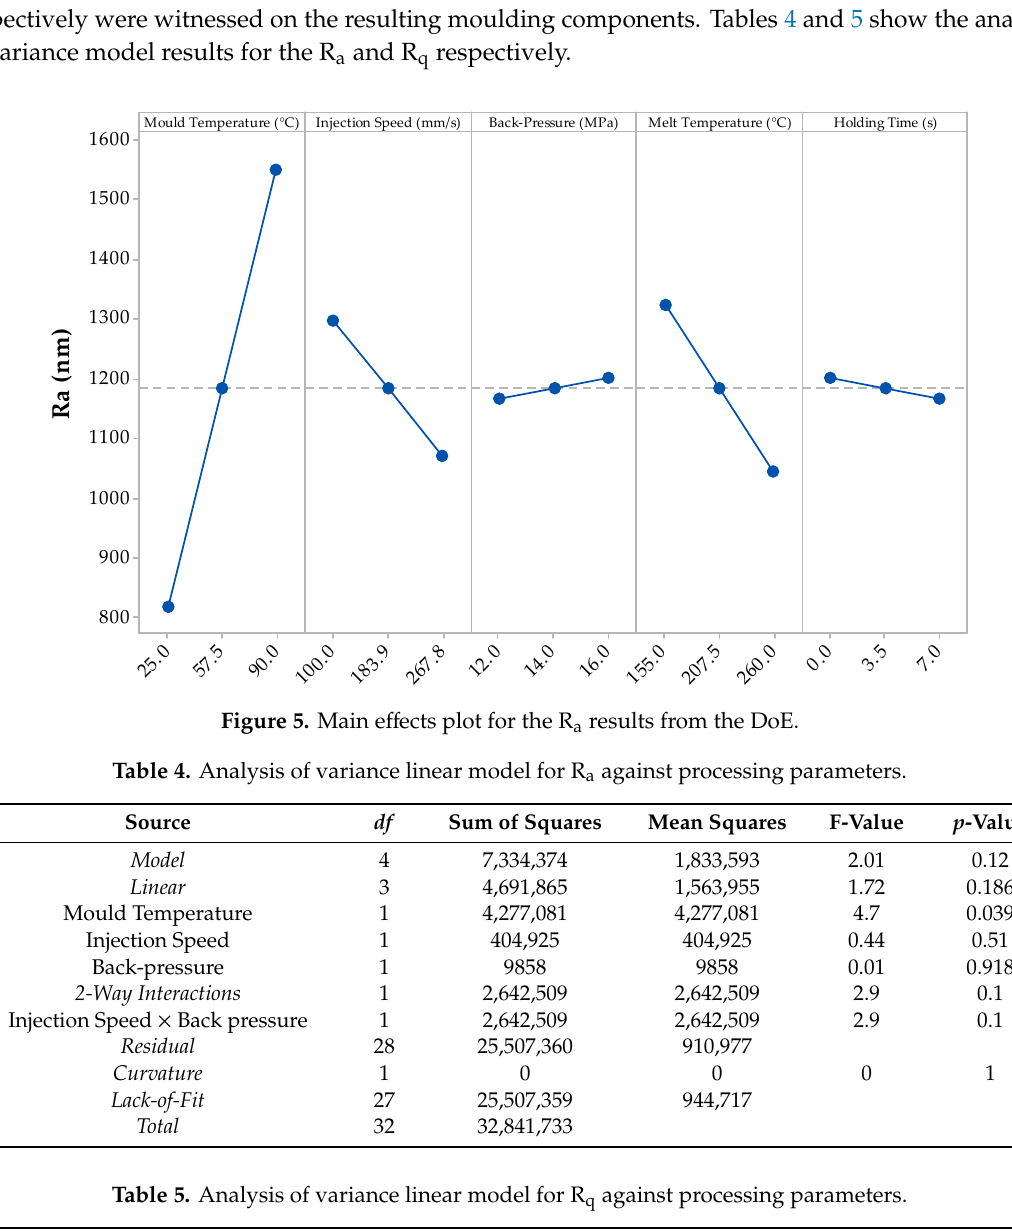
Table 4. Analysis of variance linear model for R a against processing parameters.